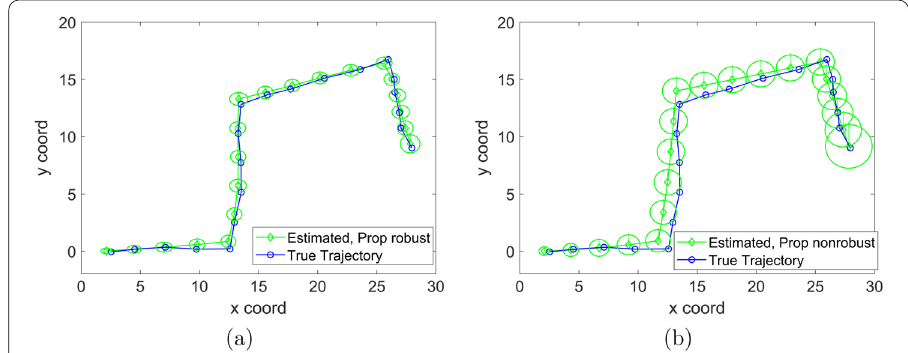
Fig. 9 Estimated poses and 95% confidence ellipses using proposed method for linear motion with outliers with α = 0.1 . a With M-estimator and b without M-estimator